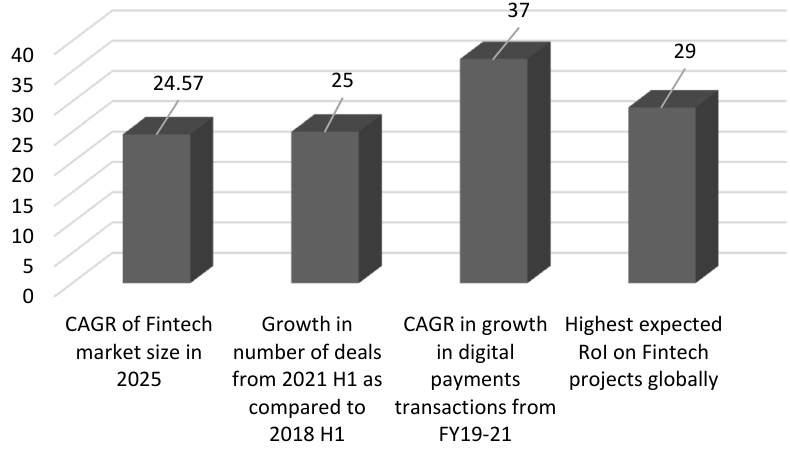
Figure 1. Statistics that explain India’s position as a global fintech market (Invest India 2022). The companies that are listed on the BSE (Bombay Stock Exchange) are chosen to obtain data on fintech return volatility. As of the 8 February 2022, there are 5246 companies listed on the Bombay Stock Exchange (BSE 2022). The term “fintech” appears in the names